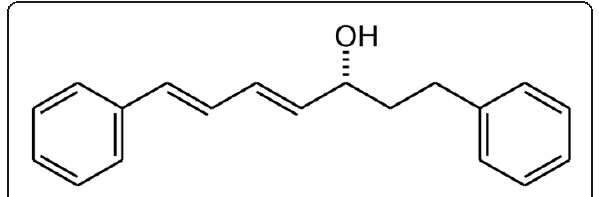
Figure 1 Structure of (3 R )-1,7-diphenyl-(4 E ,6 E )-4,6-heptadien-3- ol: compound 049